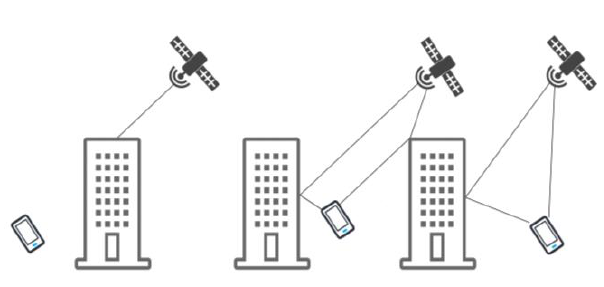
Figure 1. Types of Multipath that can occur in urban scenario (The left one present signal blockage, the middle one happens when NLOS signals are received, and the right one shows when NLOS and LOS are received